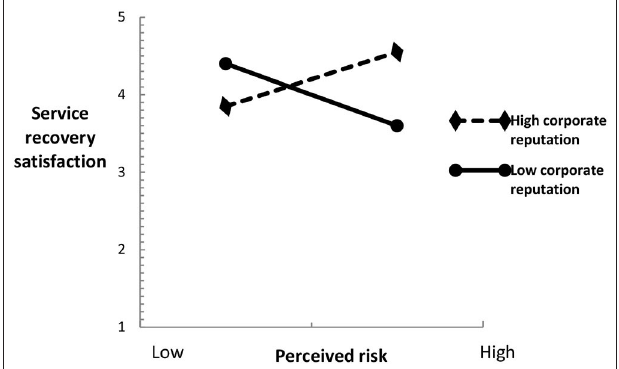
FIGURE 2 | Moderating role chart.